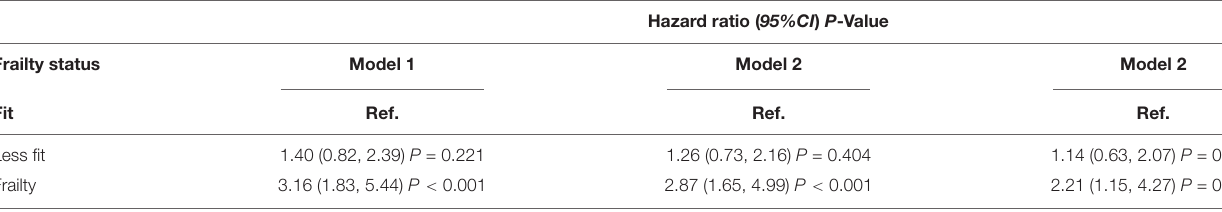
TABLE 2 | Association between frailty status and new-onset AF in unadjusted and adjusted models.